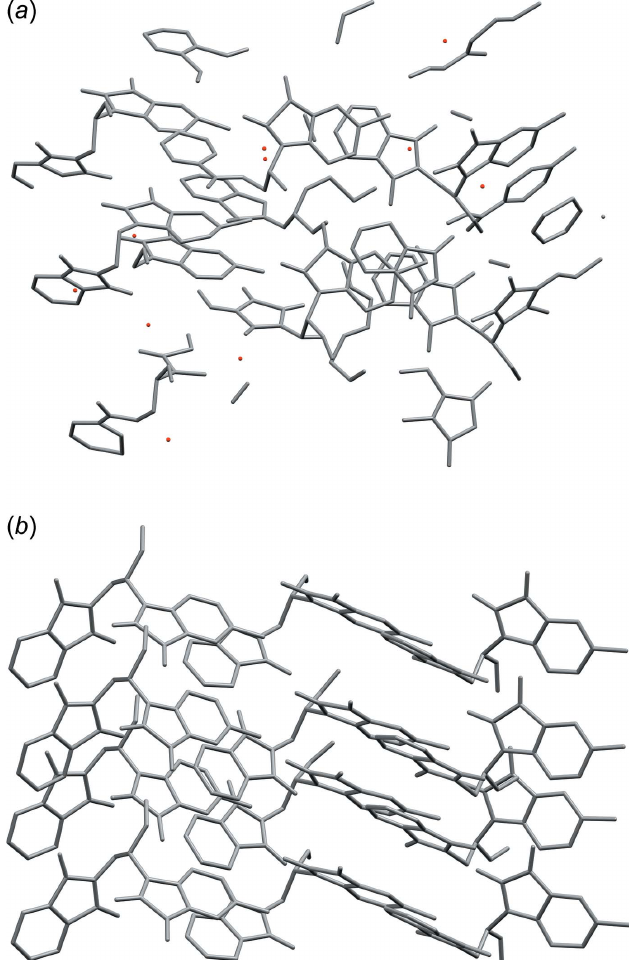
Figure 8 (a) Initial P 2 1 , Z 0 = 12 structure solution for WUGLES. ( b ) P 2 1 , Z 0 = 12 structure after model building and isotropic refinement. Diagrams generated using Mercury (Macrae et al. ,